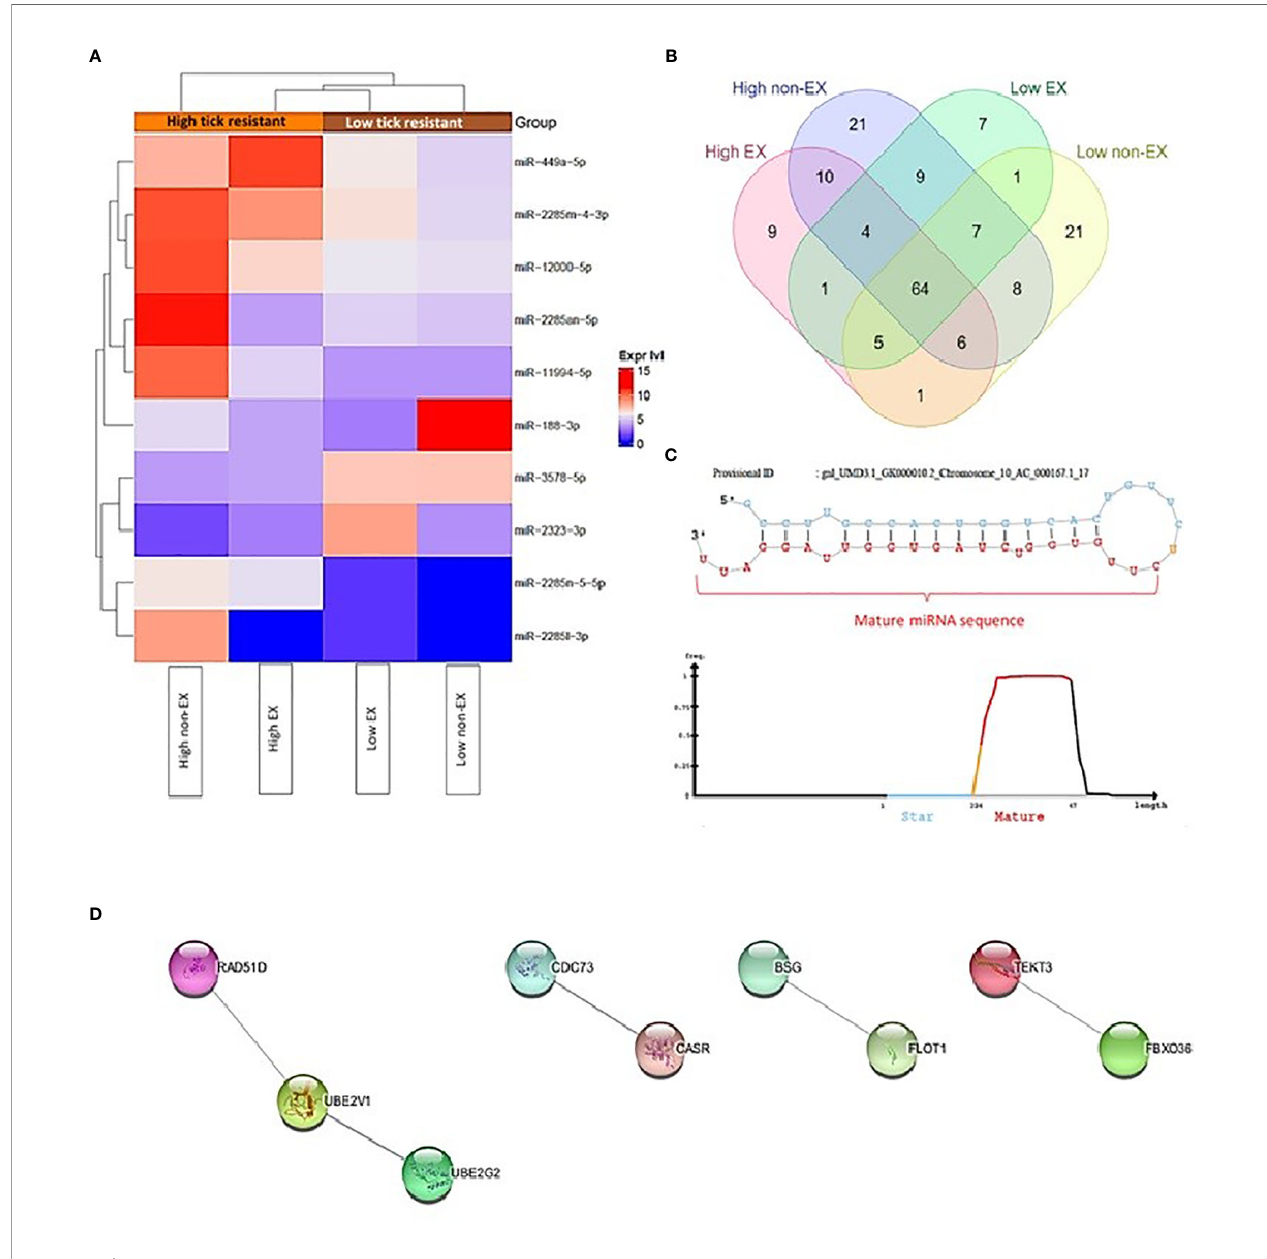
FIGURE 3 | (A) Heatmap of differential expression of miRNAs between high and low tick resistant mother plasma SEC samples (EX and non-EX) (B) Novel miRNAs distributed among high and low tick resistant mother plasma SEC samples (EX and non-EX) (C) An exemplary novel miRNA loop which shows the predicted mature miRNA sequence (D) Protein-Protein interaction (PPI) networks generated by StringDB for the 37 gene targets predicted by miRmapper, TargetScan, miRmapper & miRWalk (Singletons are not included on the fi